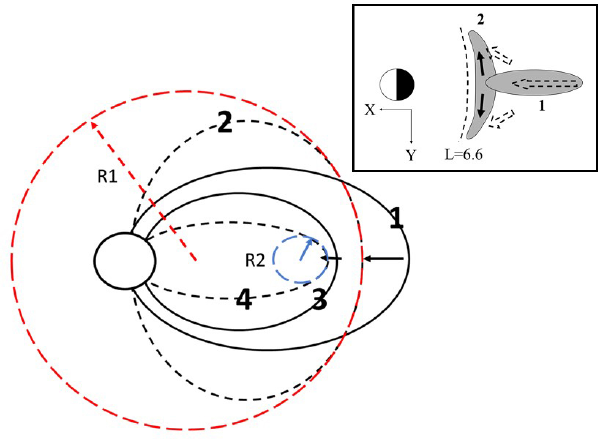
Figure 6. A schematic illustration of the field line deformations in the meridian plane associated with the changing curvature radius of the field lines. The outer field lines marked by (1) changed to field lines (2) by increasing their curvature radius to R1 (red dashed circle) in association with the relaxation of radial inhomogeneity, while the inner field lines marked by (3) moved to field lines (4) of smaller curvature radius R2 (blue dashed circle). This transition, (3) to (4), may be caused by the radial gradient of magnetic pres- sures becoming steeper in association with the inward compres- sion of the field lines (see text). In the inset, flux tube deforma- tions in the equatorial cross section are illustrated at onset locations (field lines 1 and 2). Divergence of perpendicular flows in dawn– dusk directions (solid arrows) produced a dawn–dusk expansion of flux tubes (2) which coincide with the shrinkage of stretched flux tubes (1). Flux tube deformation from (1) to (2) tended to preserve the total magnetic fluxes in the equatorial cross